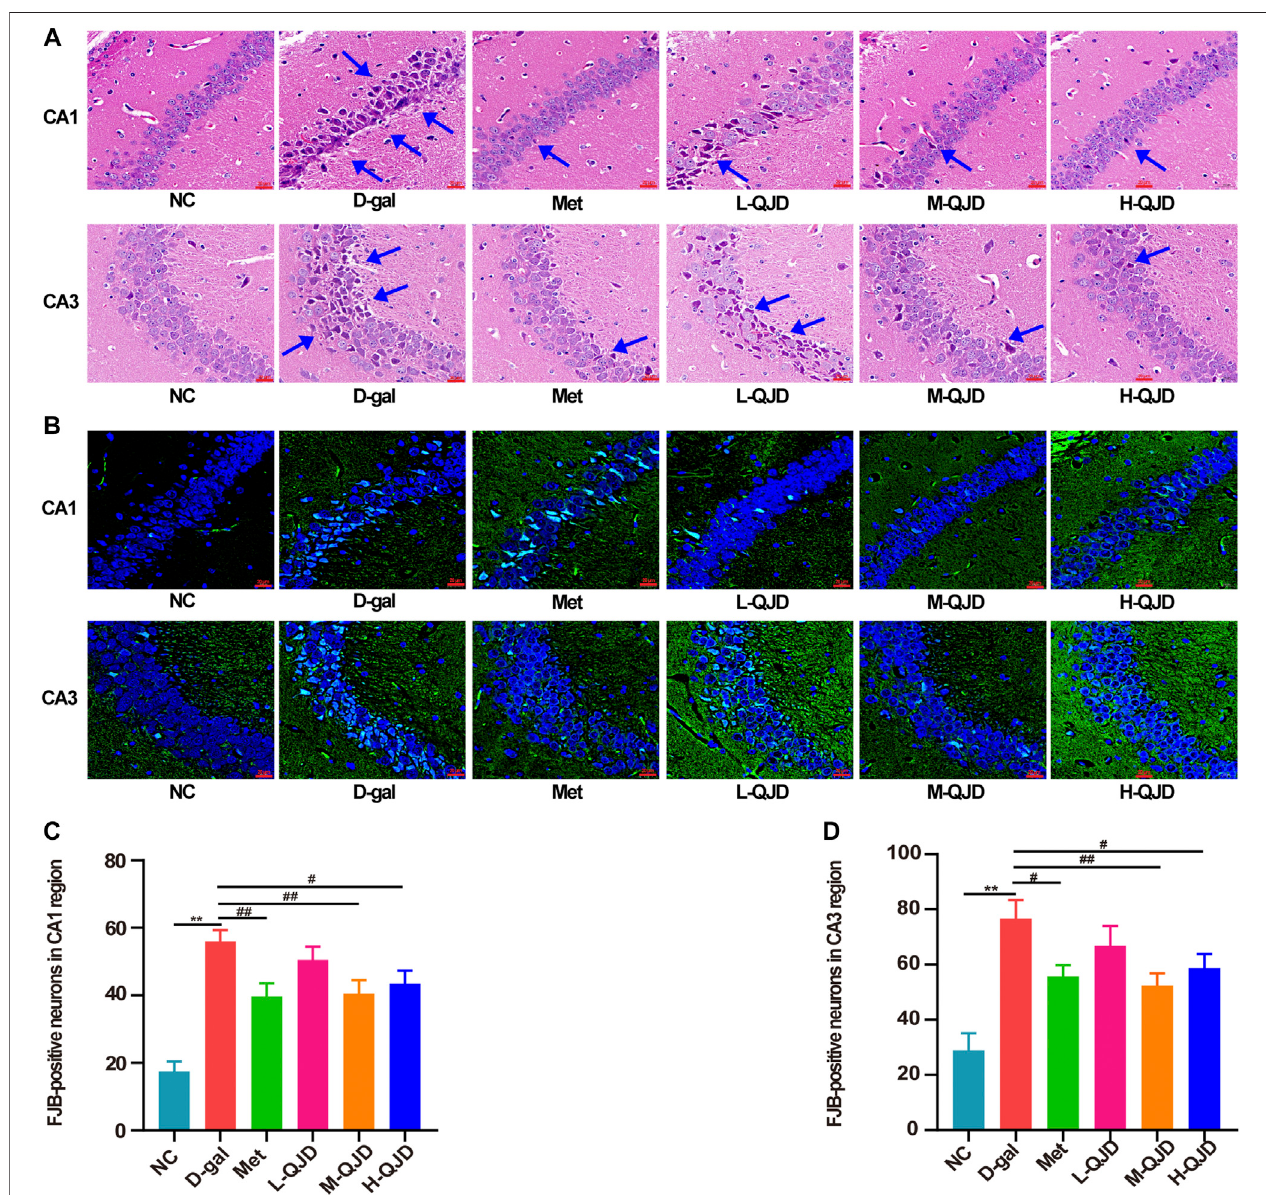
FIGURE 2 | QJD alleviated the pathological alterations in the hippocampus of D-gal – induced mice. (A) Representative HE staining images in the hippocampus of CA1 and CA3 regions (magni fi cation × 400; scale bar (cid:1) 20 μ m). (B) Representative FJB staining images (labeled in green) in the hippocampus of CA1 and CA3 regions (magni fi cation × 400; scale bar: 20 μ m). (C) Number of FJB-positive neurons in the hippocampus CA1 region. (D) Number of FJB-positive neurons in the hippocampus CA3 region. The blue arrows indicate damaged neurons in thehippocampus. Alldata were presented asmean ± SEM( n (cid:1) 4/group). ** p < 0.01 vs. NC group; # p < 0.05 and ## p < 0.01 vs. D-gal